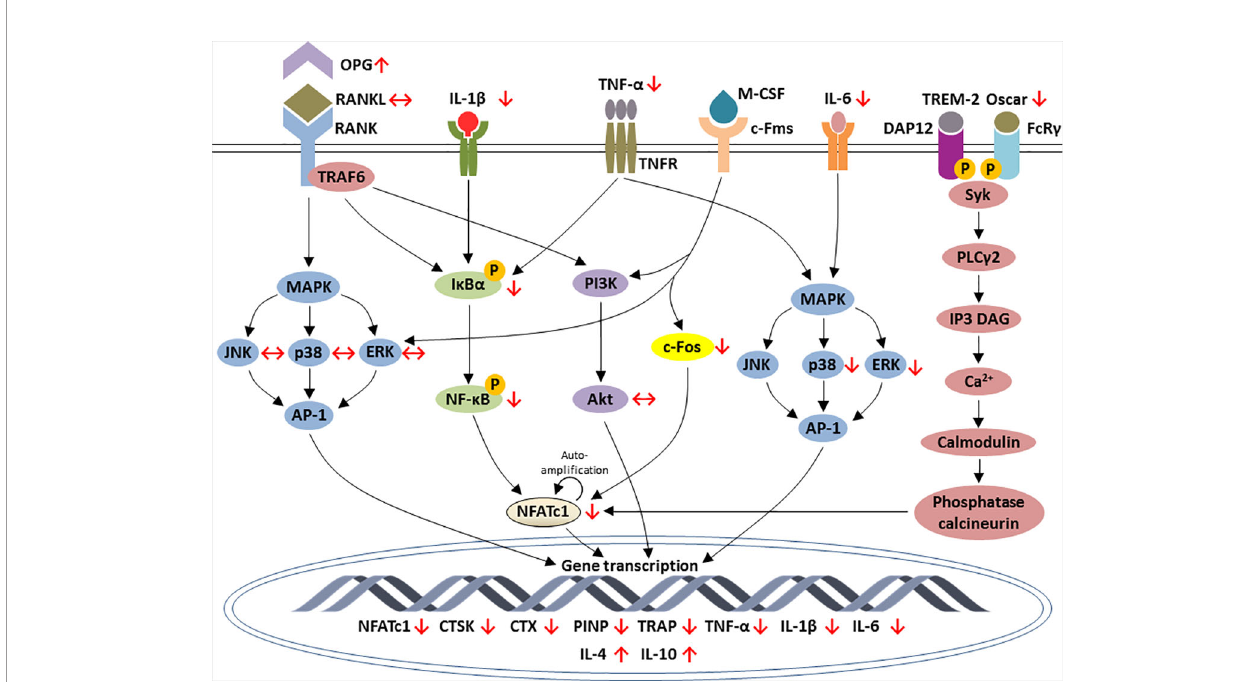
FIGURE 2 | Schematic diagram depicting the regulation of osteoclastic-speci fi c genes expression by lithium through macrophage-colony stimulating factor (M-CSF), nuclear factor-kappa B (RANK)/RANK ligand (RANKL)/osteoprotegerin (OPG), NF- k B, mitogen-activated protein kinase (MAPK), and calcium signaling pathways. Lithium increases the expression of OPG and reduces the in fl ammatory response that eventually leads to the inhibition of NF- k B and NFATc1. Lithium downregulates c-Fos, a downstream target of interaction between M-CSF and c-Fms, which is essential for osteoclast differentiation. Lithium exerts differential outcomes for MAPK signaling. The increases in TNF- a and IL-6 by lithium subsequently inhibits ERK and p38 phosphorylation but none of the subfamilies of MAPK is affected downstream the inhibition of RANK-RANKL interaction. In calcium signaling pathways, lithium inhibits Oscar which an important bone-speci fi c regulator for osteoclast differentiation via NFATc1 ampli fi cation. The effects of lithium are indicated by red arrows. Arrow pointing upward ( ↑ ) indicates an increase and pointing downward ( ↓ ) indicates a decrease. Equivalent arrow ( ↔ ) indicates no